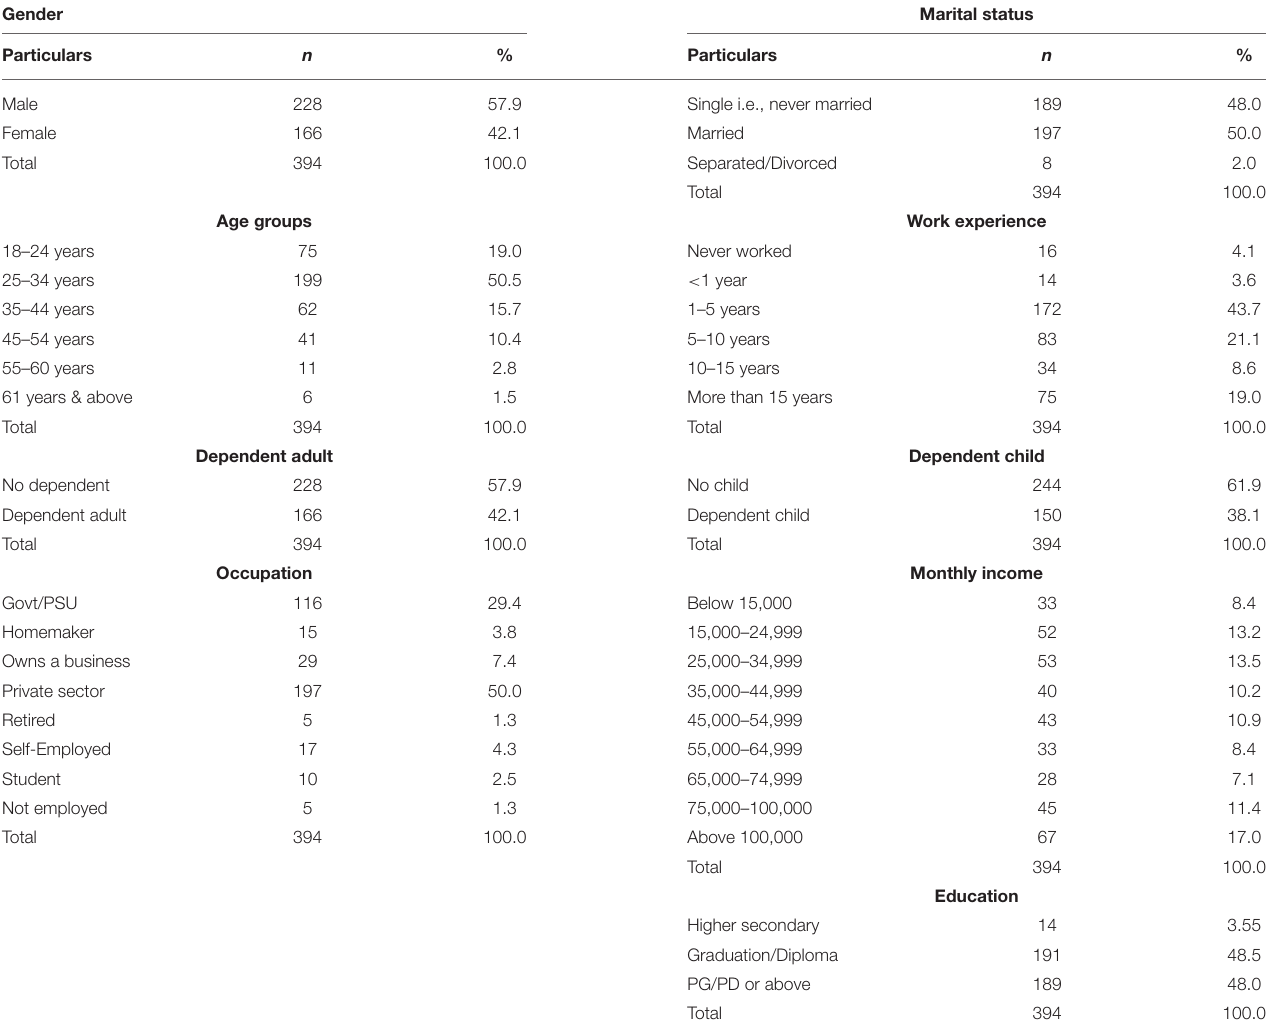
TABLE 2 | Demographic profile of